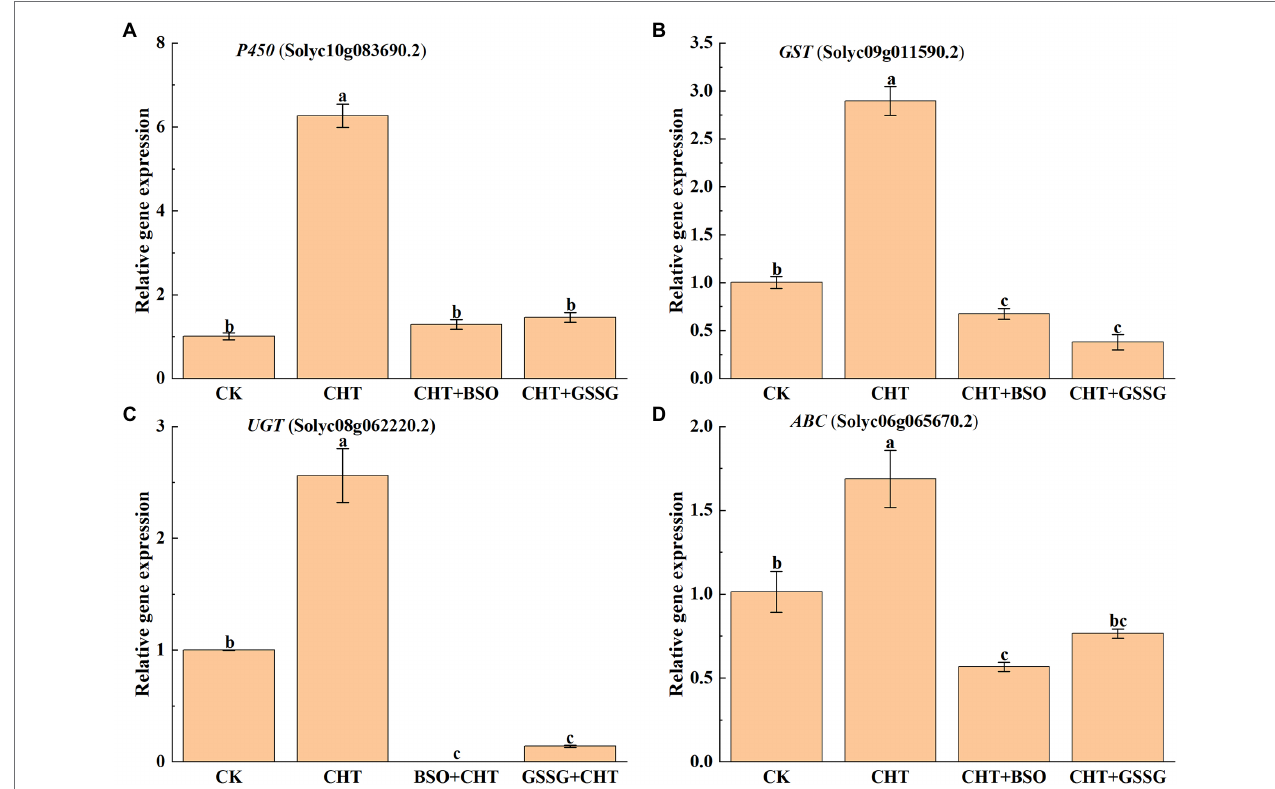
FIGURE 3 | Effects of exogenous treatment on genes’ expression related to the detoxification system in tomato. (A) P450 expression. (B) GST expression. (C) UGT expression. (D) ABC expression. P450, cytochrome P450s; GST, glutathione S-transferase; UGT, UDP-glycosyltransferases; ABC, ATP-binding cassette transporters; CHT, chlorothalonil; BSO, L-buthionine-sulfoximine; and GSSG, glutathione (oxidized). Error bars represented the SD ( n = 3). According to Duncan’s multiple test, bars with different letters were significantly different ( p <